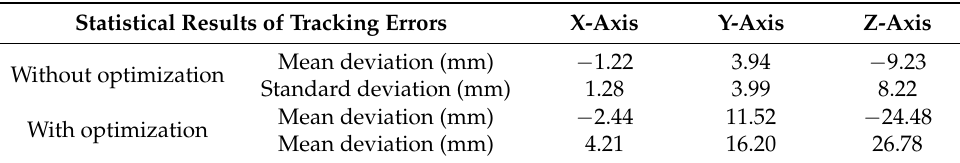
Figure 16. The tracking errors of the end effector in simulation. ( a ) Tracking error of X axis; ( b ) Track- ing error of Y axis; ( c ) Tracking error of Z axis. Table 4. Statistical results of tracking errors in triangle working path